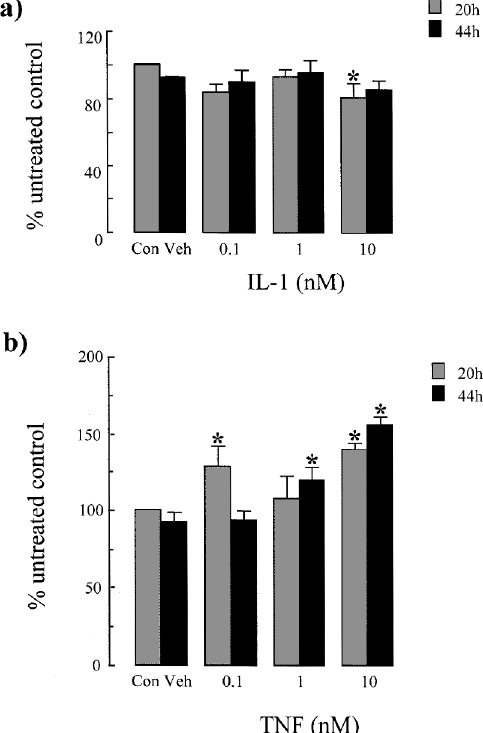
FIG. 3. The effect of: ( a ) IL-1 b and ( b ) TNF- a on eosinophil adhesion to airway smooth muscle cells after 20h of co- culture. Values are means ± SE; Con, untreated control; Veh, cytokine vehicle control; *, significantly different from cyto- kine vehicle control ( p < 0.05, n =